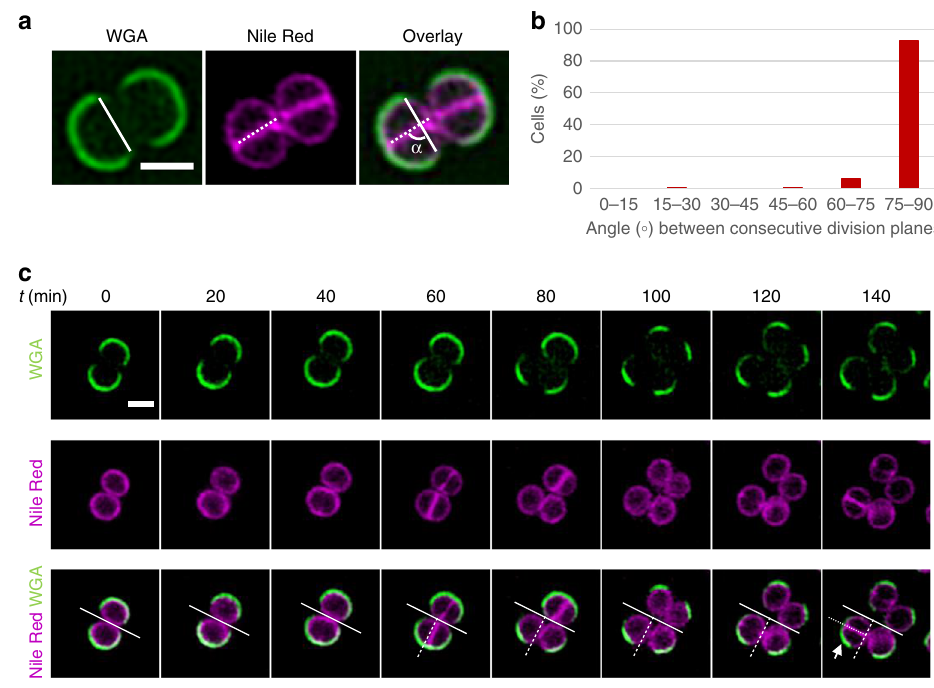
Fig. 1 S. aureus cells divide in two, but not necessarily in three, alternating orthogonal planes. S. aureus strain COL cells were initially stained with cell wall dye WGA-488 (green) and membrane dye Nile Red (magenta). Excess of non-bound WGA-488 was removed by washing and Nile Red was added again before cells were placed on a medium-containing agarose pad and imaged every 20 min by structured illumination microscopy. a The border of the WGA-488-labelled region provides information on the orientation of the previous division plane (solid line), while the Nile Red-labelled septum indicates the orientation of the current division plane (dotted line). The angle ( α ) between the solid and dotted lines corresponds to the angle between the two consecutive planes of division. b Histogram of the angle α formed between two consecutive planes of division shows that these planes are orthogonal (with an average deviation from 90° of 6.7°, n = 183 cells examined over three biological replicates). Source data are provided as a Source data fi le. c First, second and third division planes are indicated by solid, dashed and dotted lines, respectively, showing that in the cell indicated by the arrow the third division plane is parallel, not perpendicular, to the fi rst plane of division. Scale bars, 1 μ m. A full fi eld of view can be accessed in https:// fi